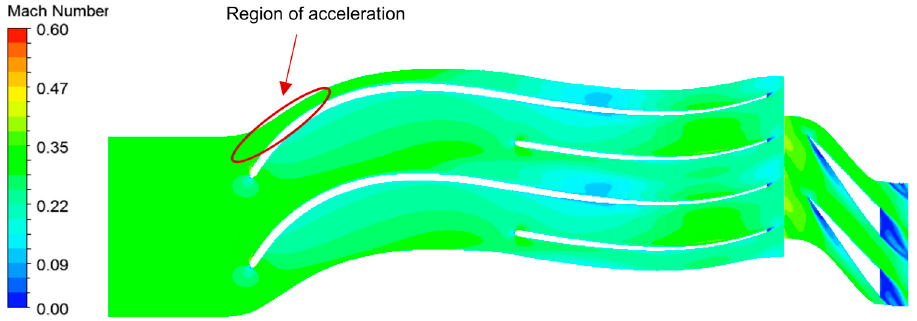
Figure 10. Blade-to-blade view of Mach number distribution.